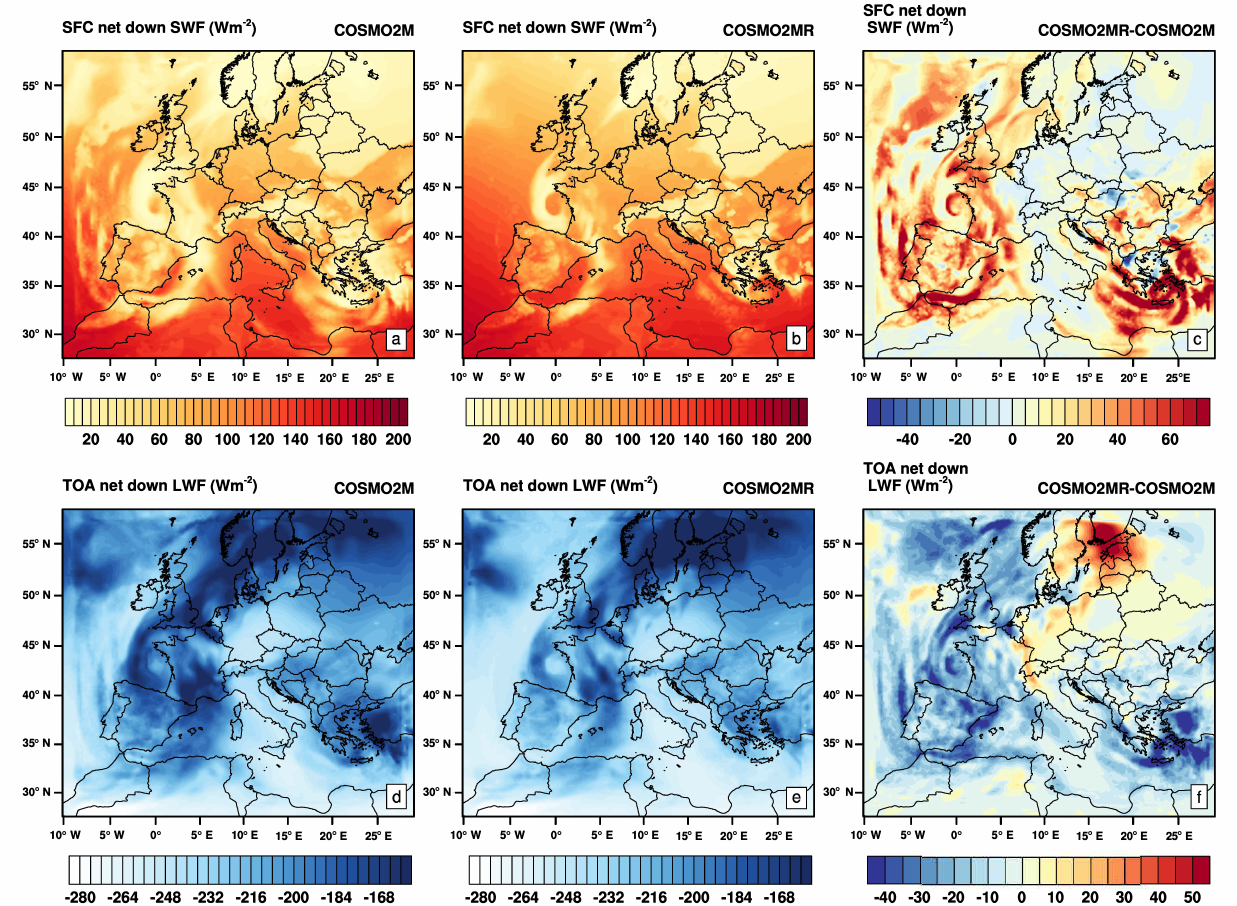
Figure 7. Comparison and difference between shortwave and longwave radiation fluxes at the surface and top of the atmosphere, and the difference between the two simulations (COSMO2MR radiation coupled minus